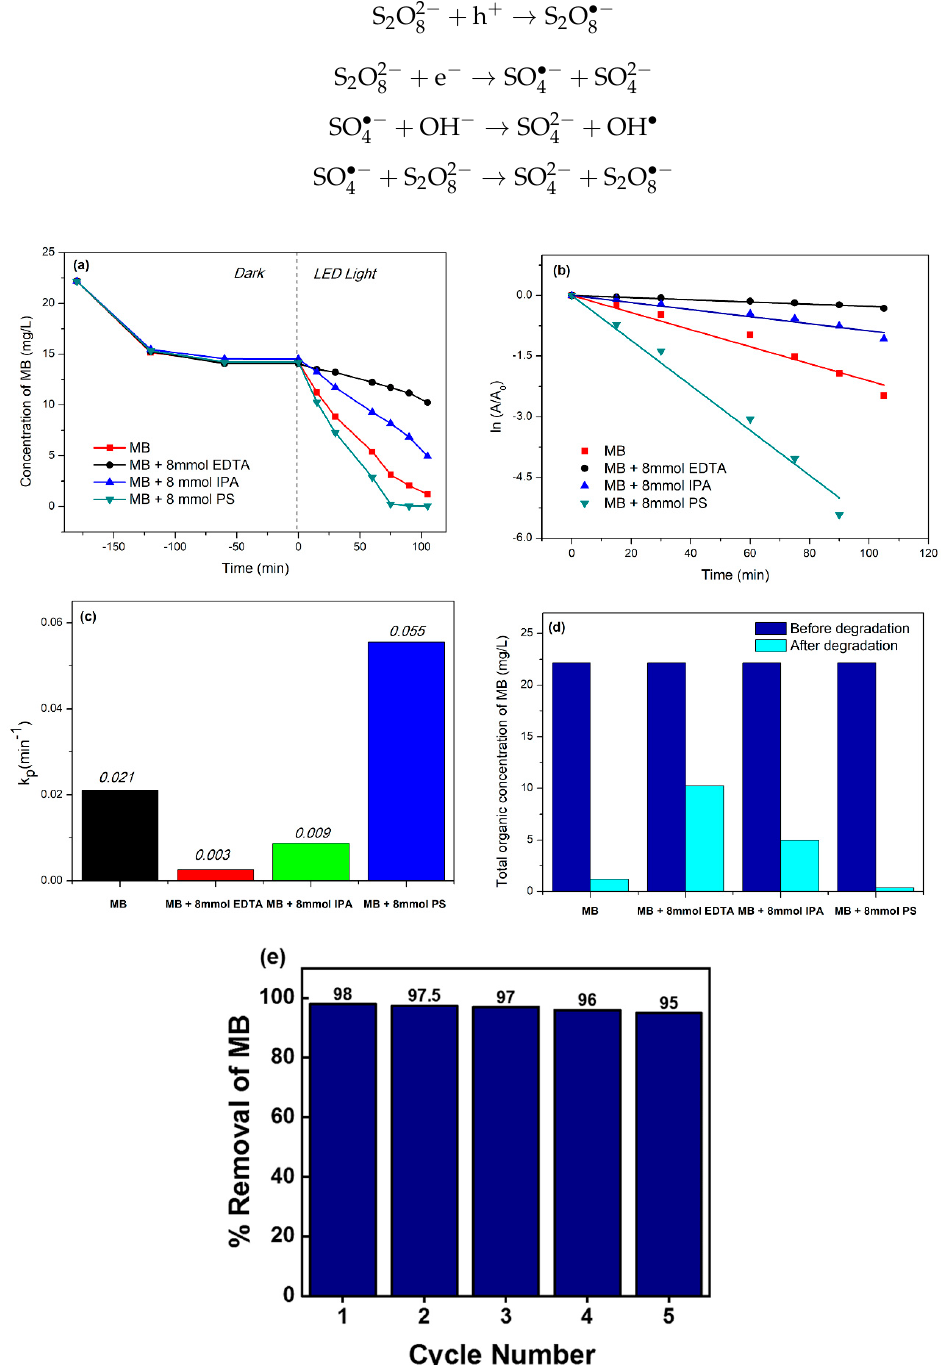
Figure 8. ( a ) Comparative degradation of the MB concentration in the presence of external reagents by (0.3)r-GOTF catalyst at different time intervals, ( b ) first-order kinetics degradation of MB by (0.3)r-GOTF catalyst, ( c ) histogram of first-order photodegradation rate constants for (0.3)r-GOTF catalyst in the presence of external reagents, ( d ) total organic concentration of MB in the photocatalysts system before and after the degradation and ( e ) reusability study of (0.3)r-GOTF. The IPA and EDTA system substantially inhibited the ultimate degradation effi- Reusability of the best performing (0.3)r-GOTF catalyst (Figure 8e) was